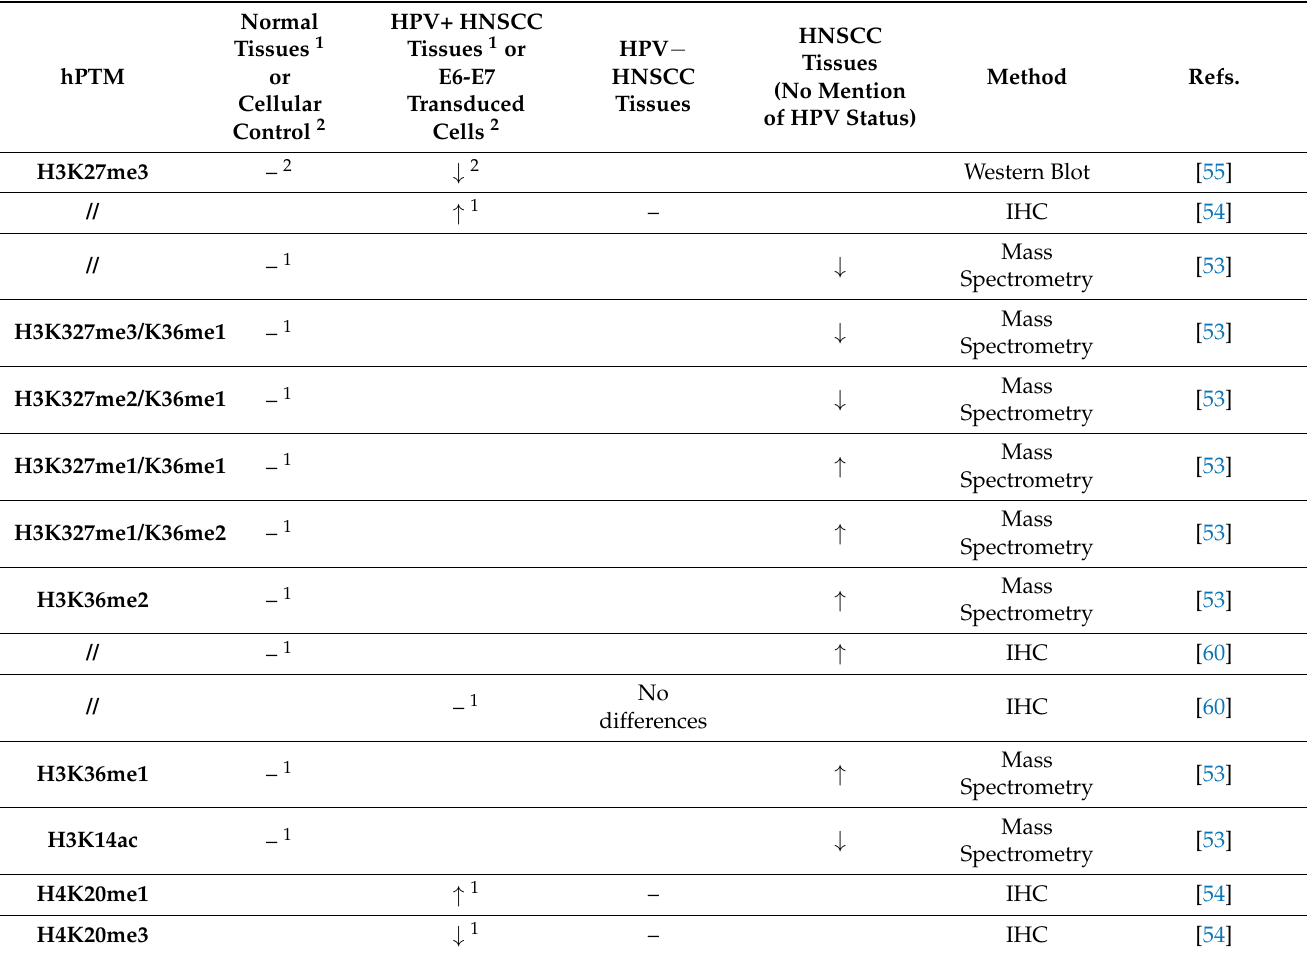
Table 2. Modulation of hPTMs in HNSCC compared to normal tissues and in HPV+ HNSCC or E6/E7 transduced cells compared respectively to HPV − HNSCC or to “Cellular Control” (empty-vector transduced cells). ↑ : upregulation; ↓ : downregulation; –: control considered for the described sample comparison. 1 and 2 are used to indicate the samples considered when two options are reported in the column title. The technical approach (“Method”) through which the hPTMs have been detected is also